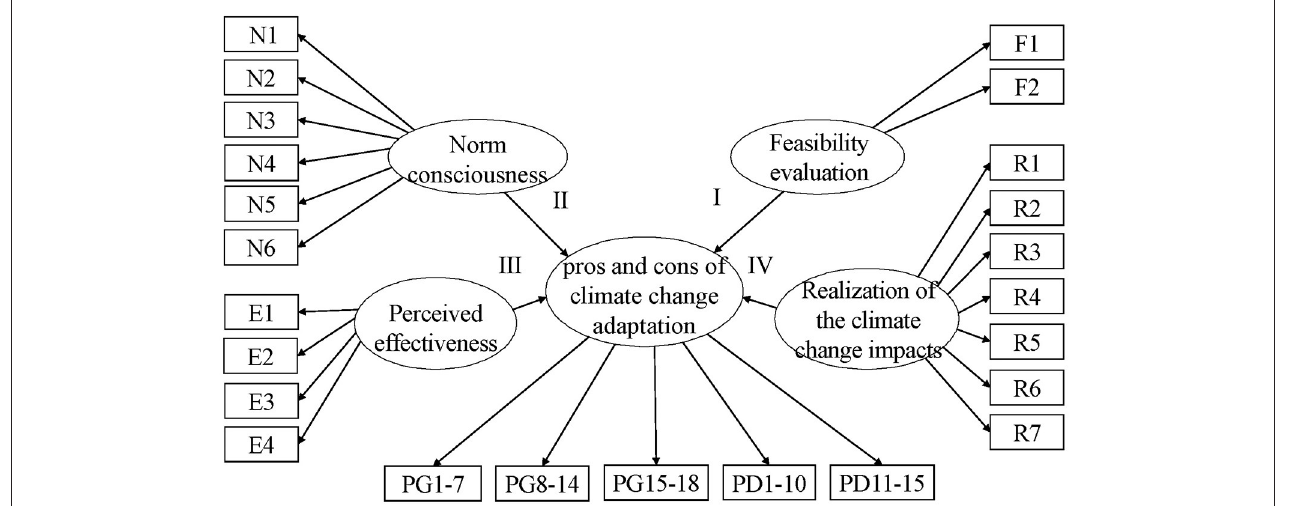
FIGURE 3 | Determinants to pros and cons of climate change adaptation policies in disaster prevention.